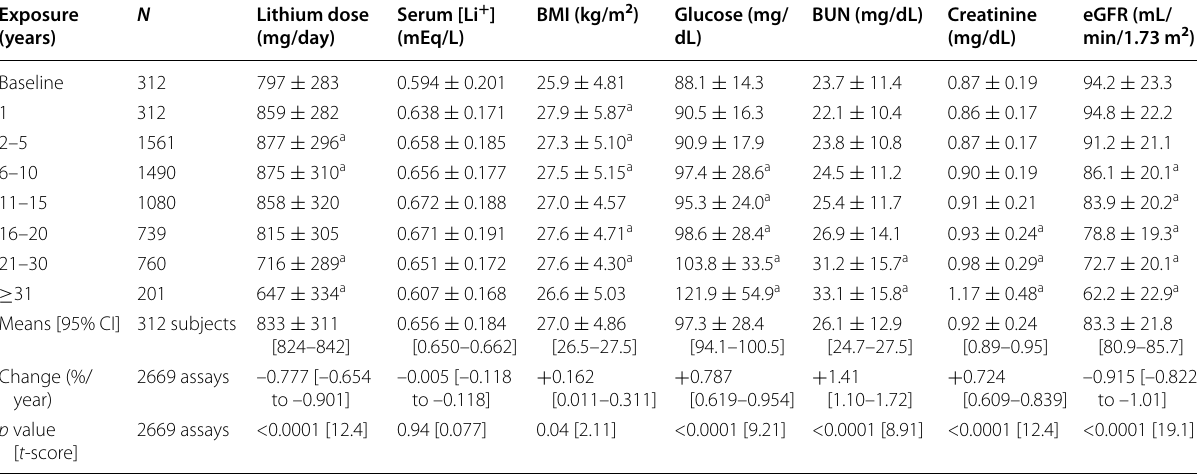
Data are based on means of N measurements (of a total of 2669) for 312 subjects over stated exposures to lithium treatment Not shown are data for white blood cell counts (WBC), which did not change appreciably (initital: 7.29, final: 7.59 BMI (body-mass index [kg/m 2 ]), BUN (blood urea nitrogen [mg/dL]), creatinine [mg/dL], eGFR (estimated glomerular filtration rate for creatinine [mL/min/1.73 m 2 ]), glucose (not necessarily fasting [mg/dL]), WBC (white blood cell count